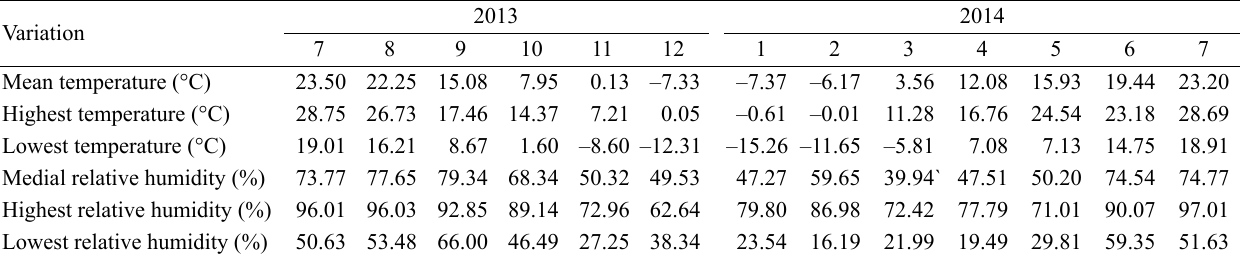
Table 1. Variation of temperature and humidity at the Fengning Experiment Base during the 12 mo of wheat storage 1